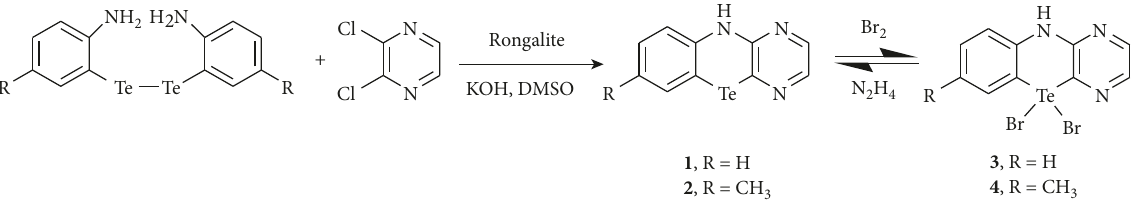
Figure 3: Preparation of 10 H -pyrazino[2,3-b][1,4]benzotellurazine and its 7-methyl derivative.